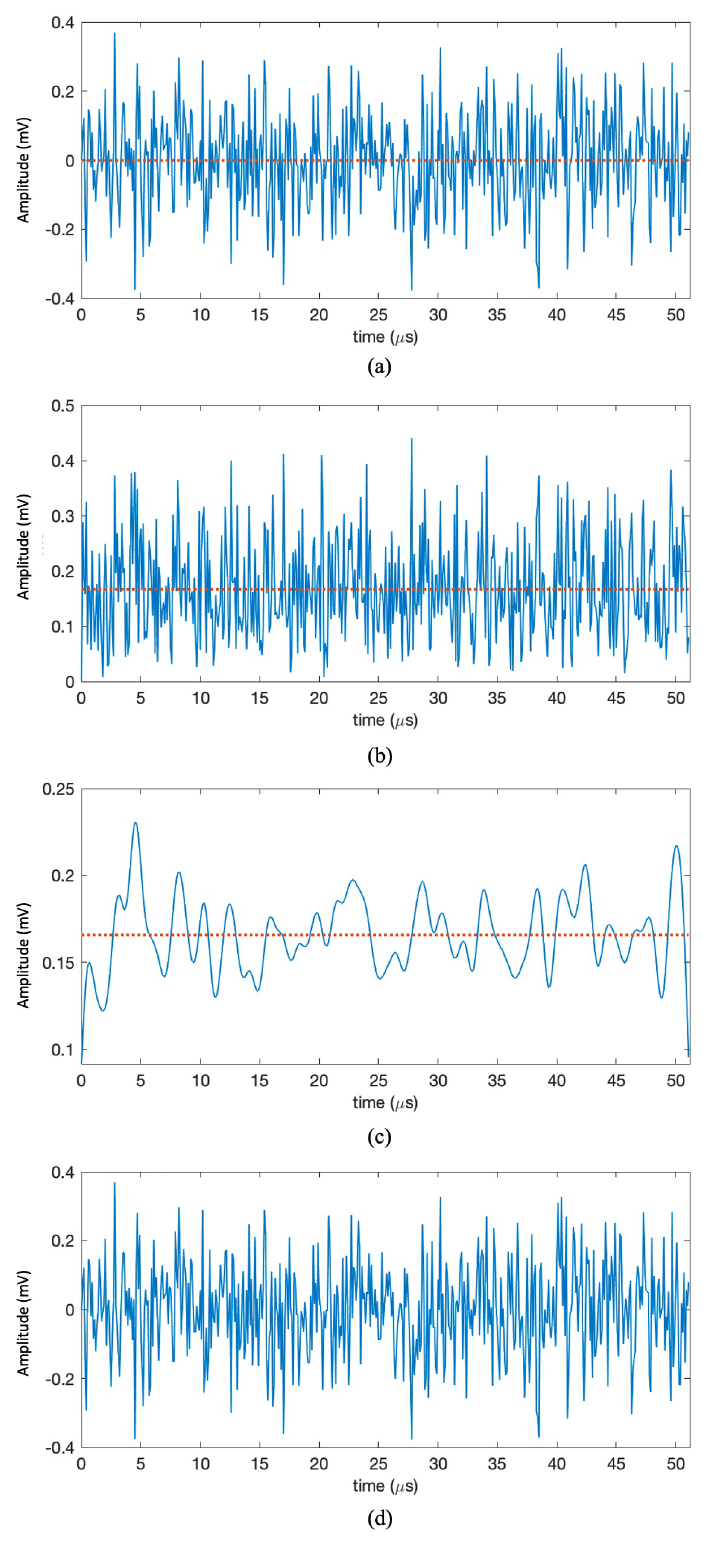
Figure 4. In the absence of interference ( label inter = 0 ) : ( a ) the real part of th received signal; ( b ) the amplitude of the received signal; ( c ) the echo envelope detected by LPF; and ( d ) the received signal that does not contain affected samples. The dashed line in the sub-figures indicates the mean value of the corresponding